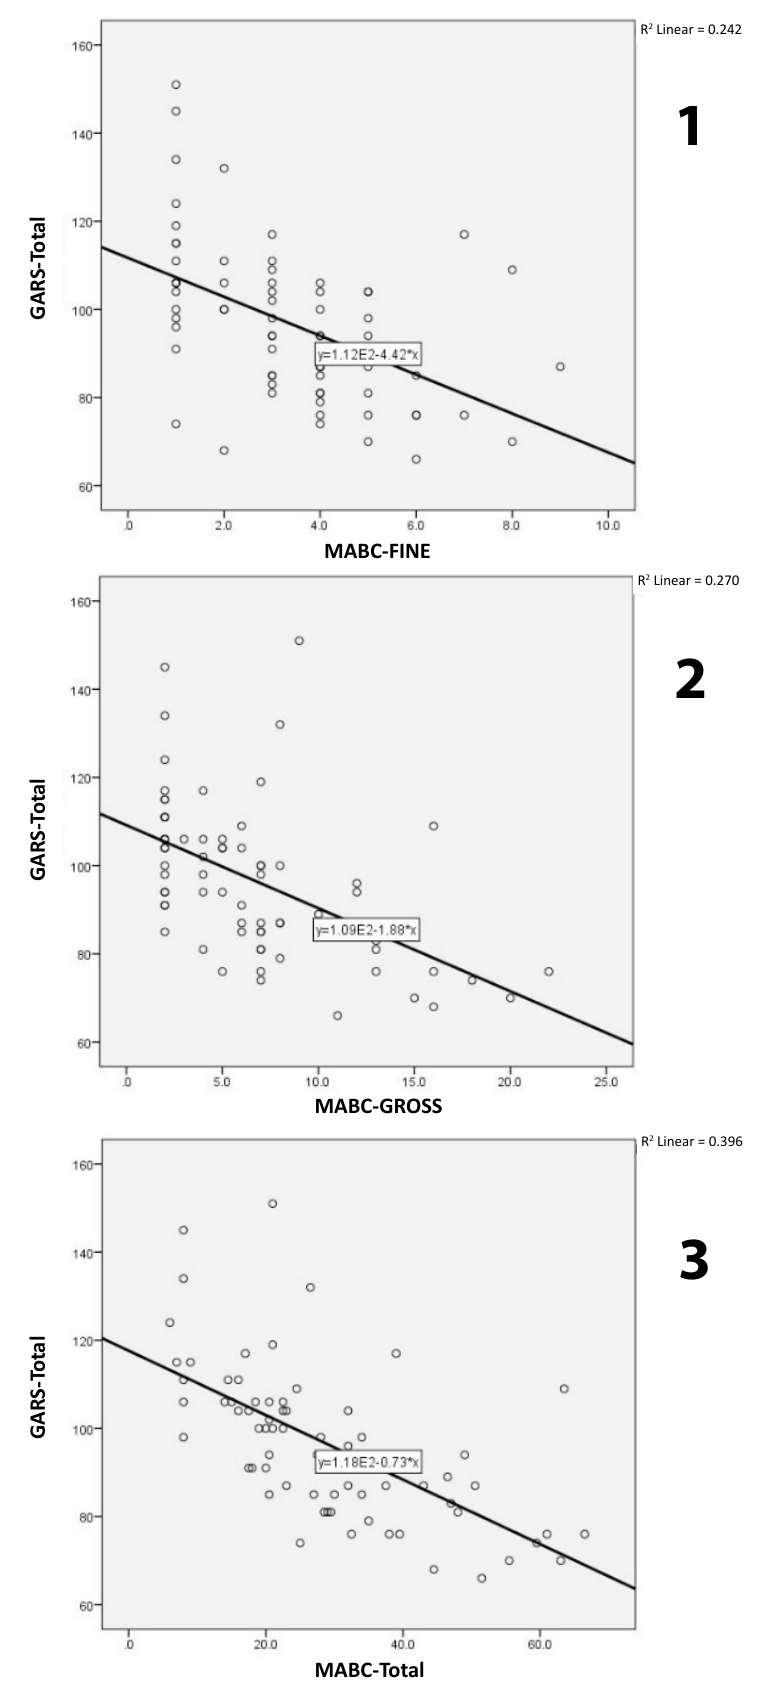
Figure 1. T he fitness of correlation in fine skill and the severity of autism disorder (1), gross skills and the severity of the disorder (2) and motor proficiency and the severity of the disorder